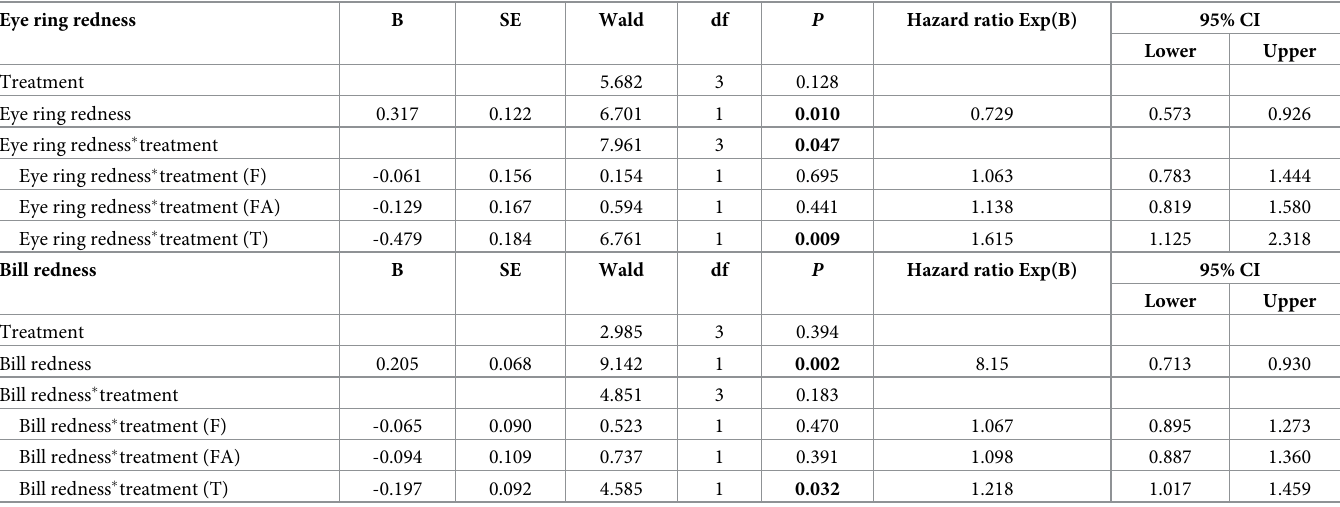
Table 1. Cox proportional-hazards regression for survival.